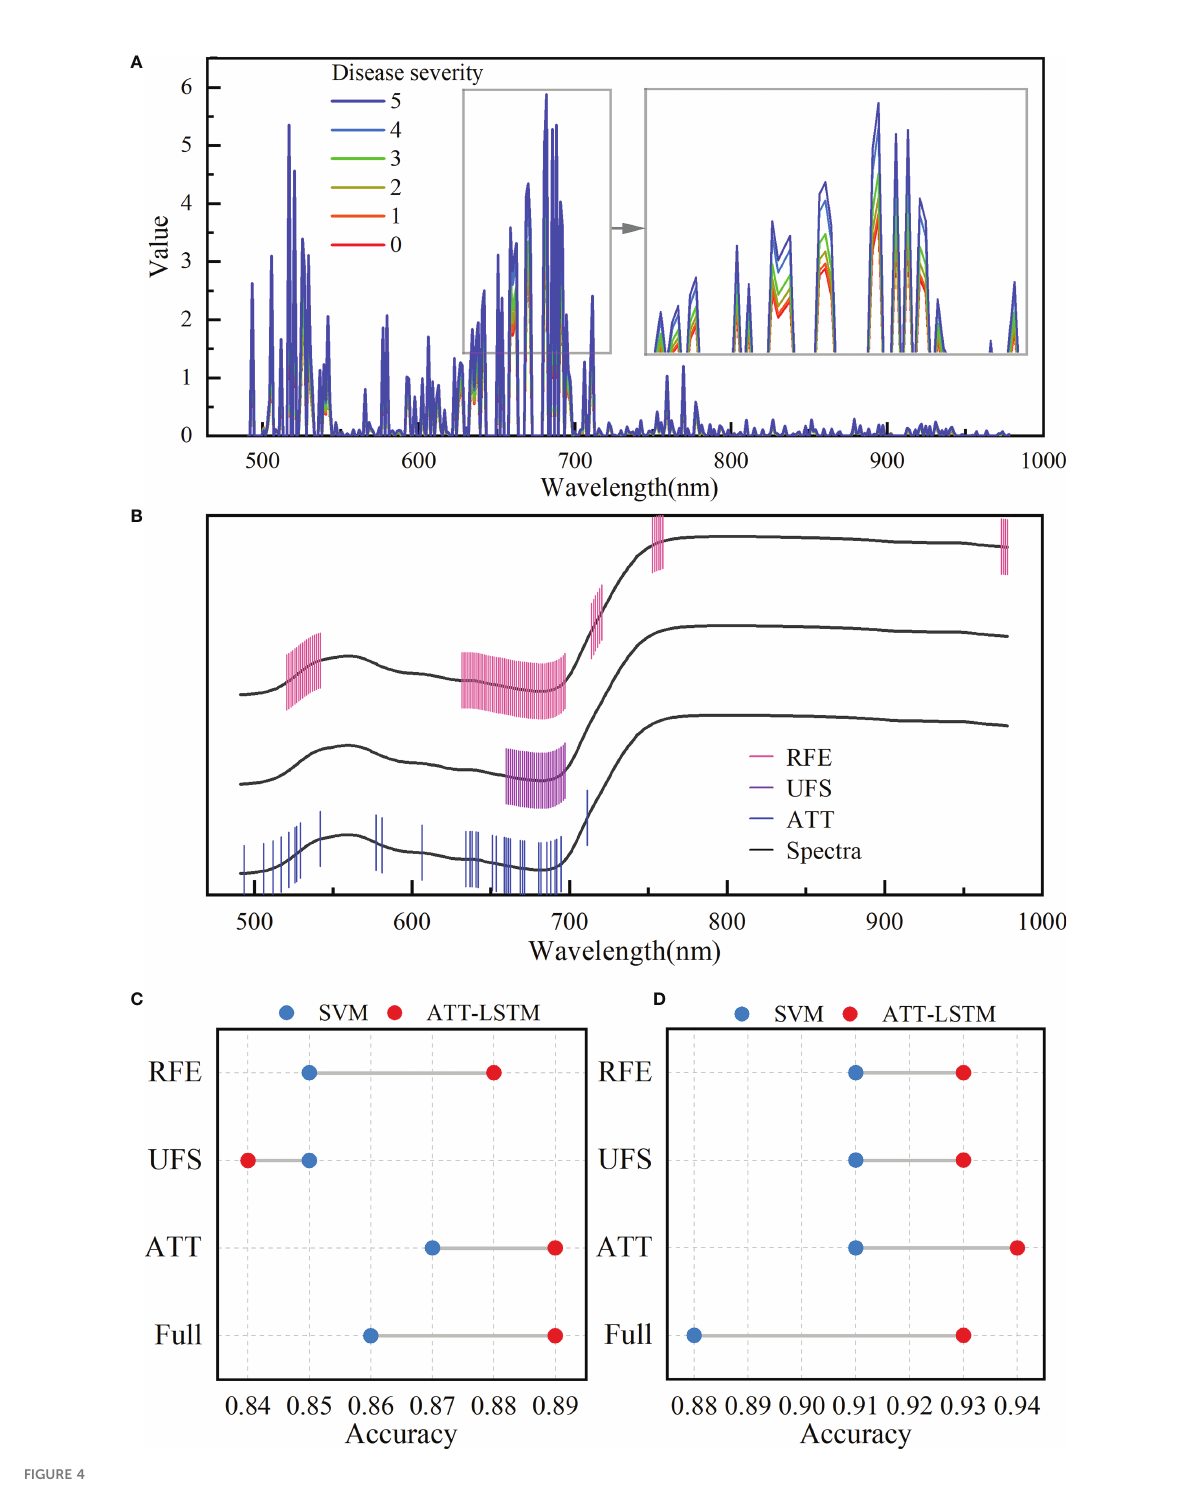
FIGURE 4 Important wavelength selection results. (A) Attention weights of different disease severity calculated by the attention block. (B) Important wavelengths selected by different methods. The black lines represent spectral pro fi les and are used only to visualize the selected wavelengths. The results of disease severity evaluation models were established by using the selected important wavelengths (C) and important wavelengths fused with color features (D) (RFE, UFS, and ATT represent for modelling with the extracted important wavelengths using the corresponding feature extraction methods, respectively; Full represents for modelling with all